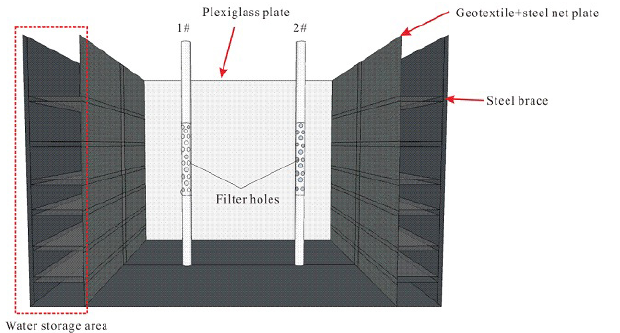
Figure 1. Front view of the model sketch